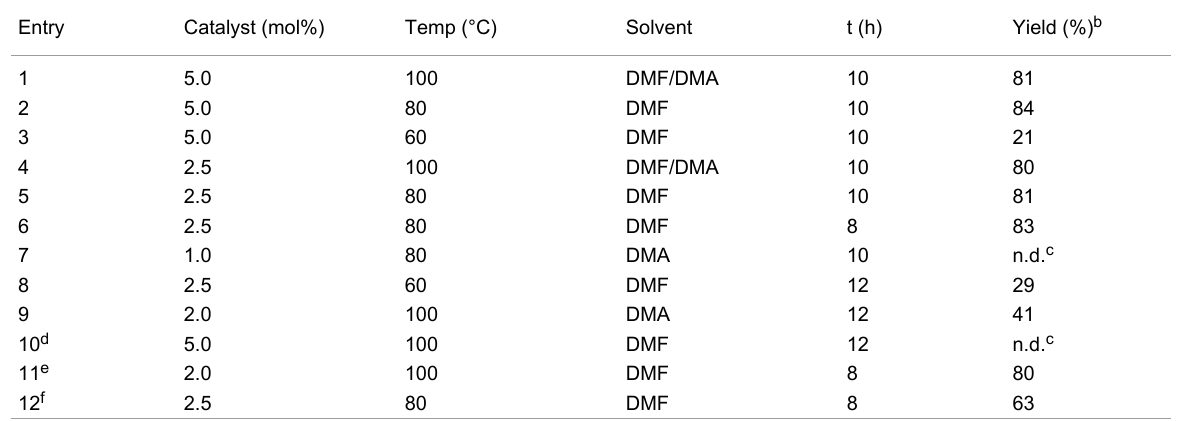
Table 1: Optimization of the reaction conditions.